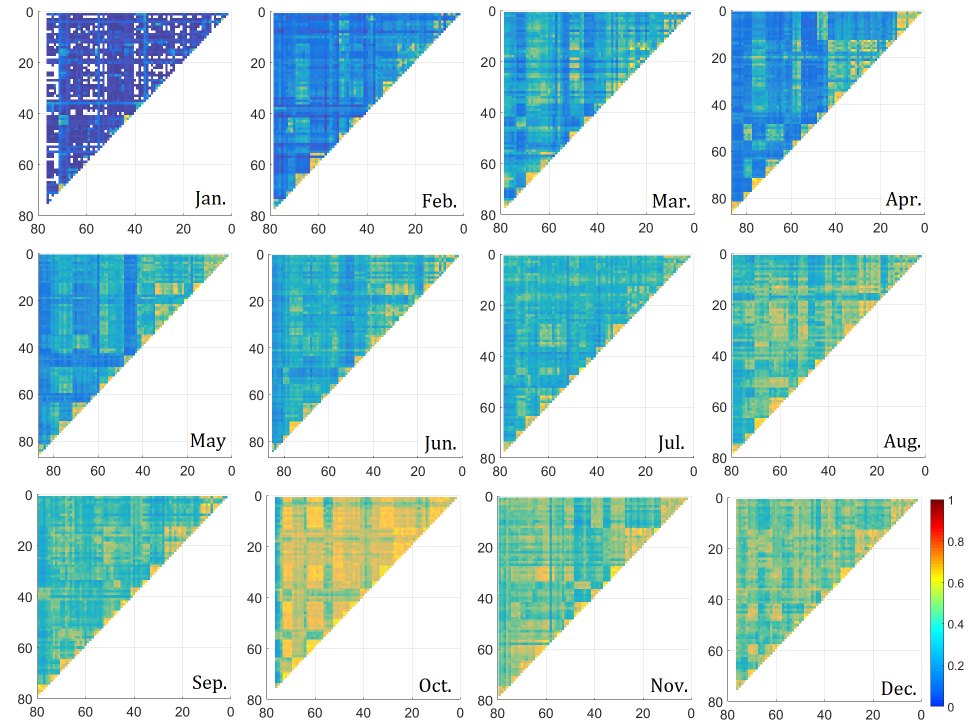
Figure 3. Triangular matrix graphs of q 0 between station pairs in the BTH Region for each month of 2019. The principal diagonal of the triangular matrix is not shown since it represents the self-tail dependence of one station and equals 1.